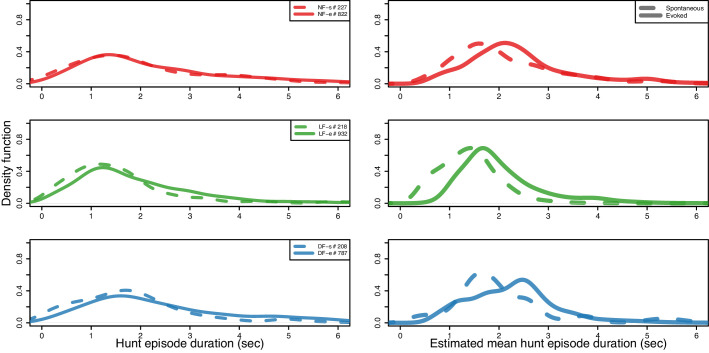
Hunt episode duration shorter in LF group in both spontaneous and evoked hunt events.(Right) Comparing mean hunt episode durations by fitting a Gamma distribution model to pooled hunt-episode duration data for each group’s spontaneous (dashed) and evoked hunt evens (solid). Hunt episode duration shorter in LF group in both spontaneous μsNF=2.1,μsDF=2.0, μsLF=1.4 , with probability P[μsL⁢F<μsN⁢F]=0.80, P[μsL⁢F<μsD⁢F]=0.75, and evoked hunt events μeNF=2.5,μeDF=2.3, μeLF=2.0, with probability P[μeL⁢F<μeN⁢F]=0.65, P[μeL⁢F<μeD⁢F]=0.69. An increase in mean episode duration between spontaneous (no prey) and evoked hunt events is mostly evident in LF and less so in NF hunt events, which are likely to show similar episode durations between conditions (P[μeNF>μsNF]=0.56). (Left) Kernel density (BW = 0.25 s) estimation using recorded data from spontaneous and evoked hunting events. Distributions across conditions and groups show large overlap in episode duration. 95% of the spontaneous hunt-episode duration data are below 3.5 s. for LF, while this interval includes 78% of NF and 88% of DF. The NF group’s 95% percentile is at 5.02 s. indicating that there are some comparatively longer spontaneous events in this group.